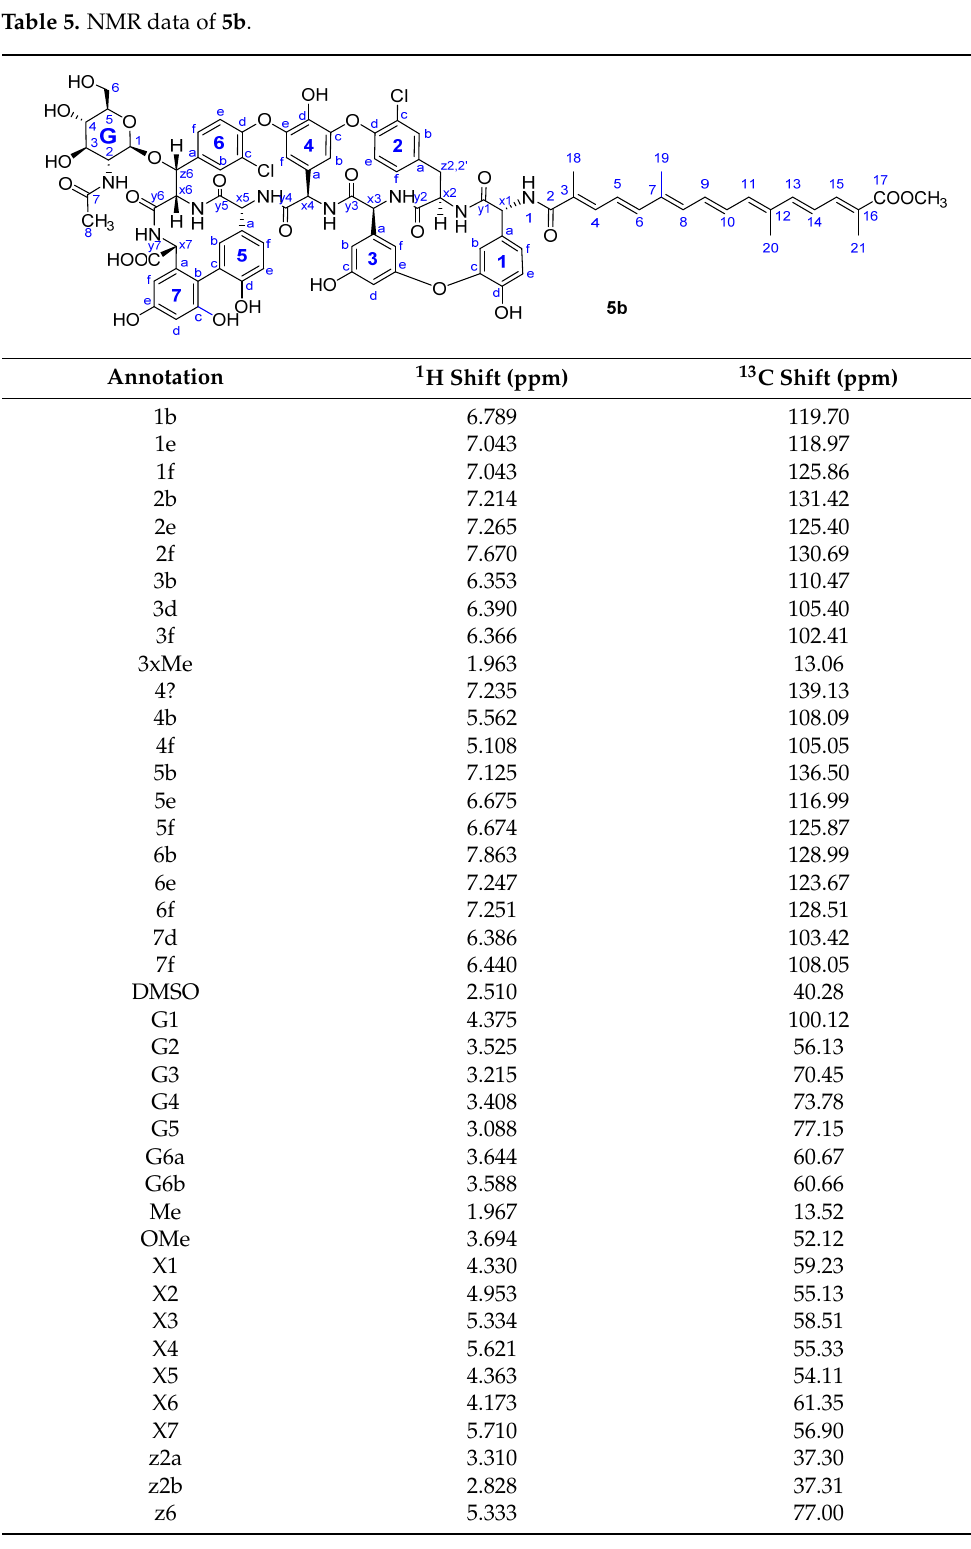
Compound 5c : yield 47.5 mg (53%, HPLC purity 96.6%), red powder; R f = 0.29 (toluene/MeOH 1:1); NMR data of 5c are shown in Table 6. HRMS (ESI): m/z calcd for C 96 H 95 Cl 2 N 8 O 24 +Na + : 1859.5626 [ M -H+2Na] + ; found: